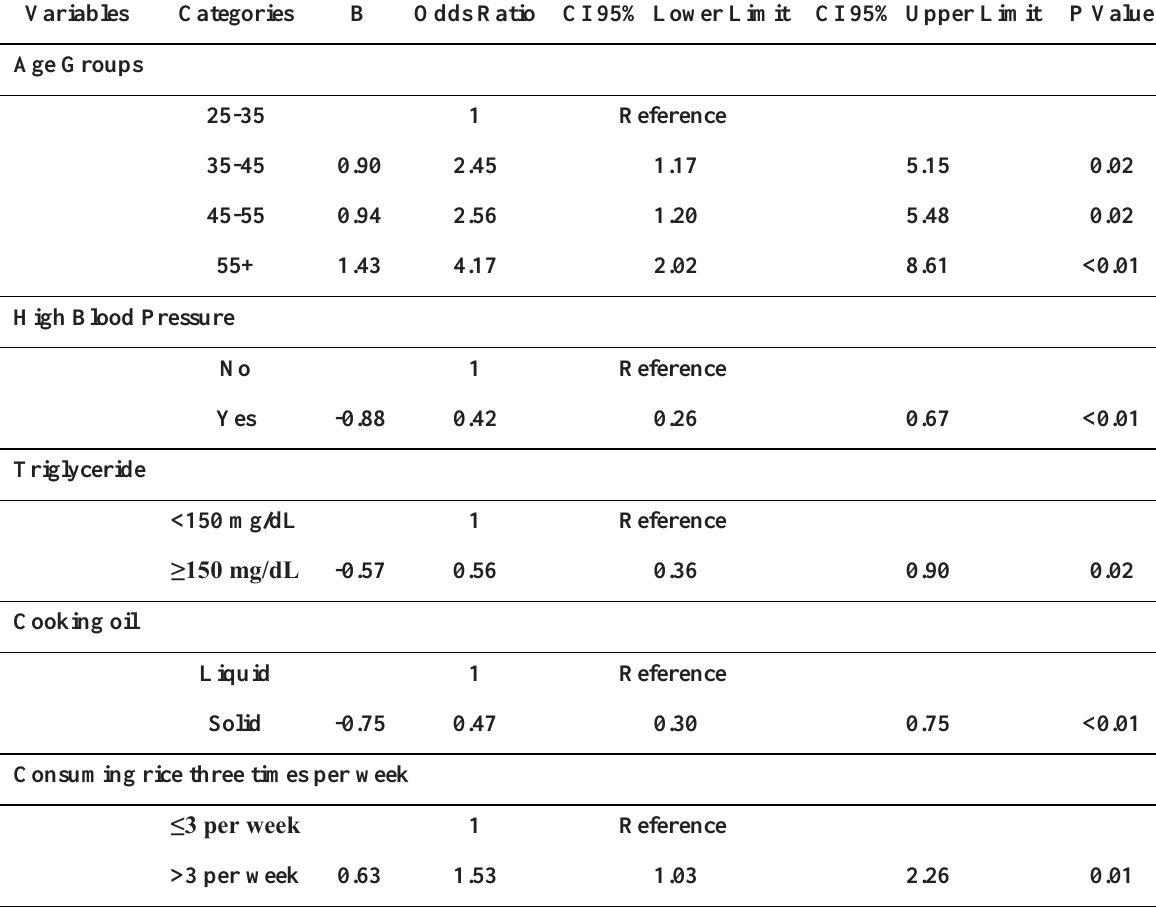
Table 2. Multivariable analysis of risk factors and diabetes among study participants in Herat, Afghanistan